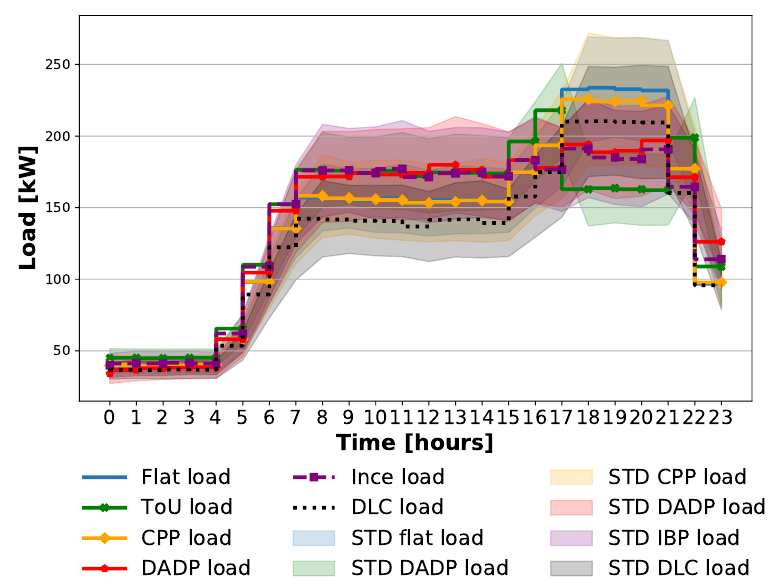
Figure 9. Daily average load for each of the DSMs and the base case.